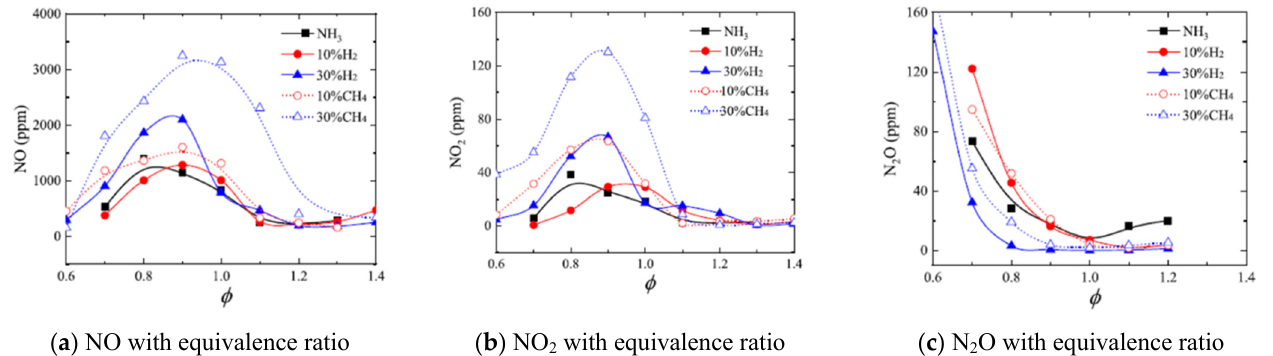
Figure 13. NOx emissions with equivalence ratio for H 2 and CH 4 blend fraction: ( a ) NO; ( b ) NO 2 ; ( c ) N 2 O. Courtesy of Elsevier [69].